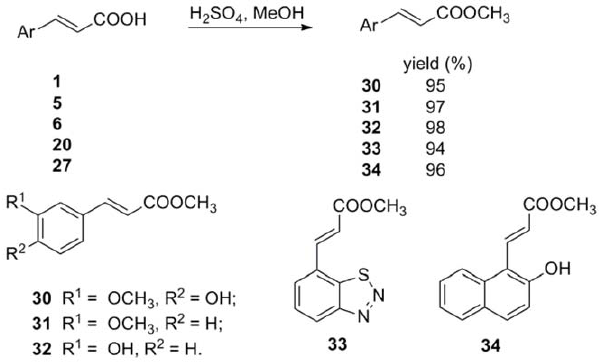
Figure 8. Synthesis of trans- 3-aryl methylacrylate 30–34.